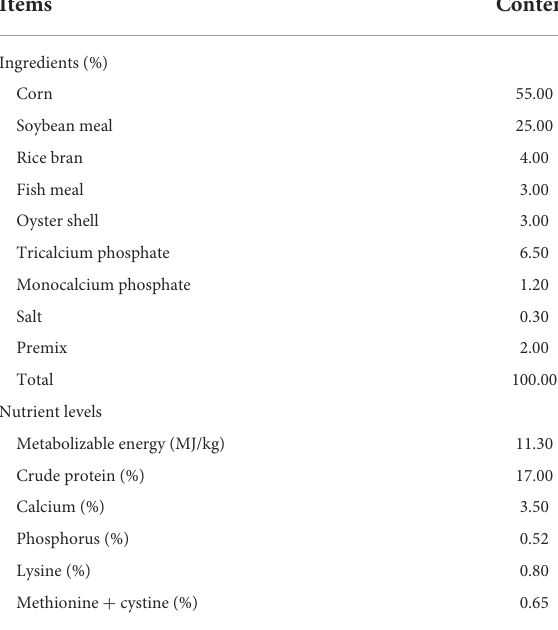
TABLE 1 Ingredients and nutrient levels of basal diet for the laying